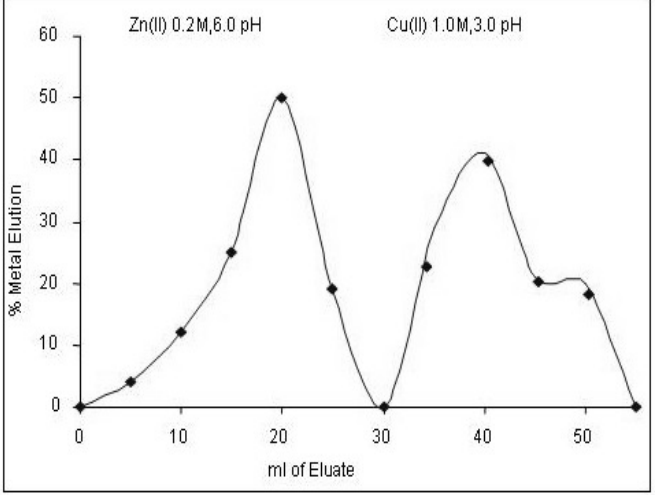
Figure 8 . Separation of Zn(II) and Cu(II) on AFM